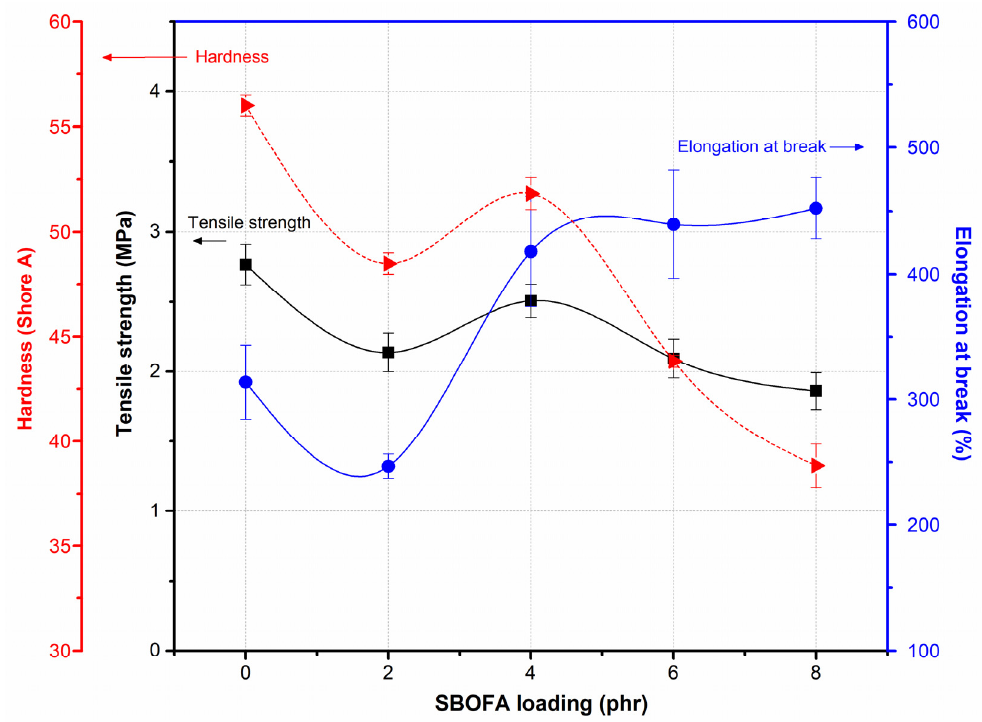
Figure 10. The tensile strength, elongation at break, and hardness of NBR vulcanizates with varying SBOFA loadings. Data of tensile properties and hardness are shown as the mean ± 1SD, derived from five and three experiments, respec- tively.